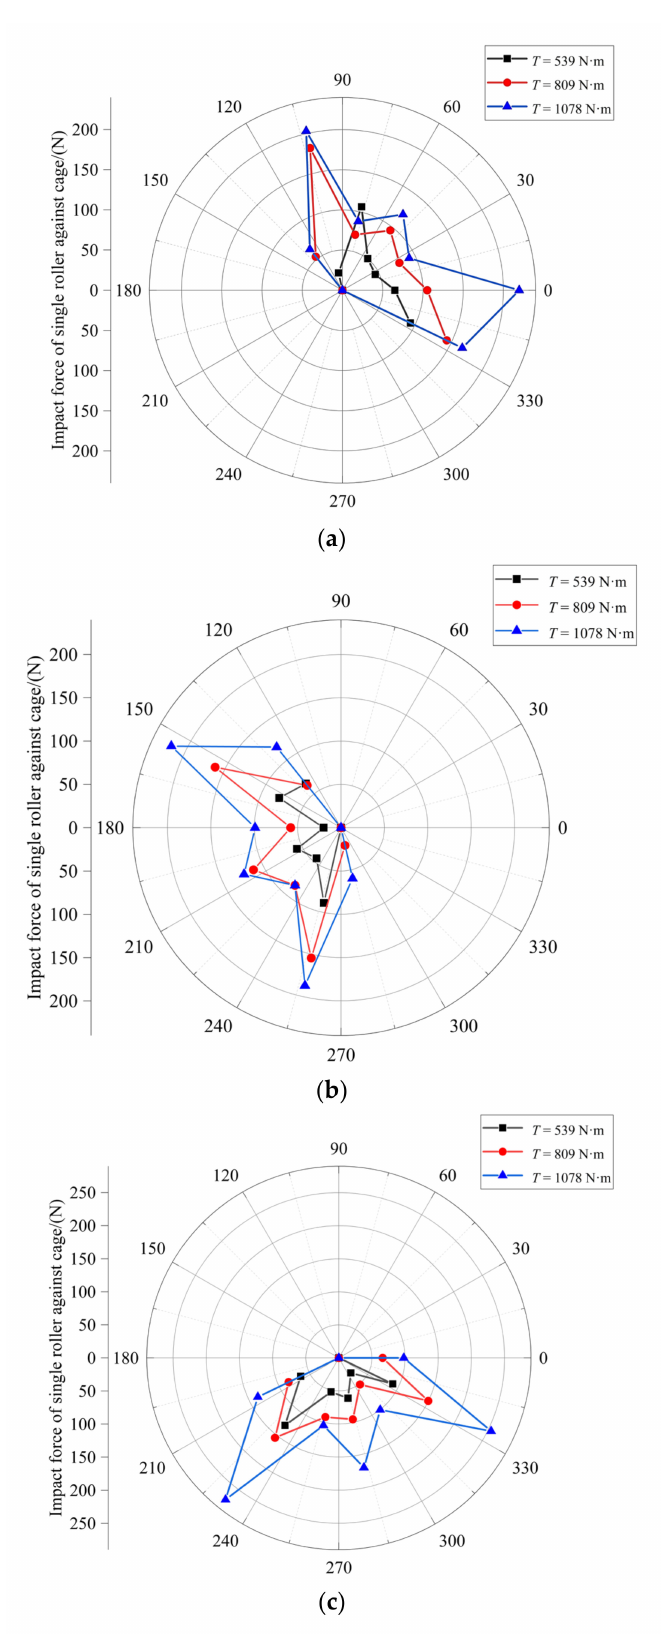
Figure 12. Impact force of roller on cage at a single moment. ( a ) cp = 0.2 mm. ( b ) cp = 0.3 mm. ( c ) cp = 0.4